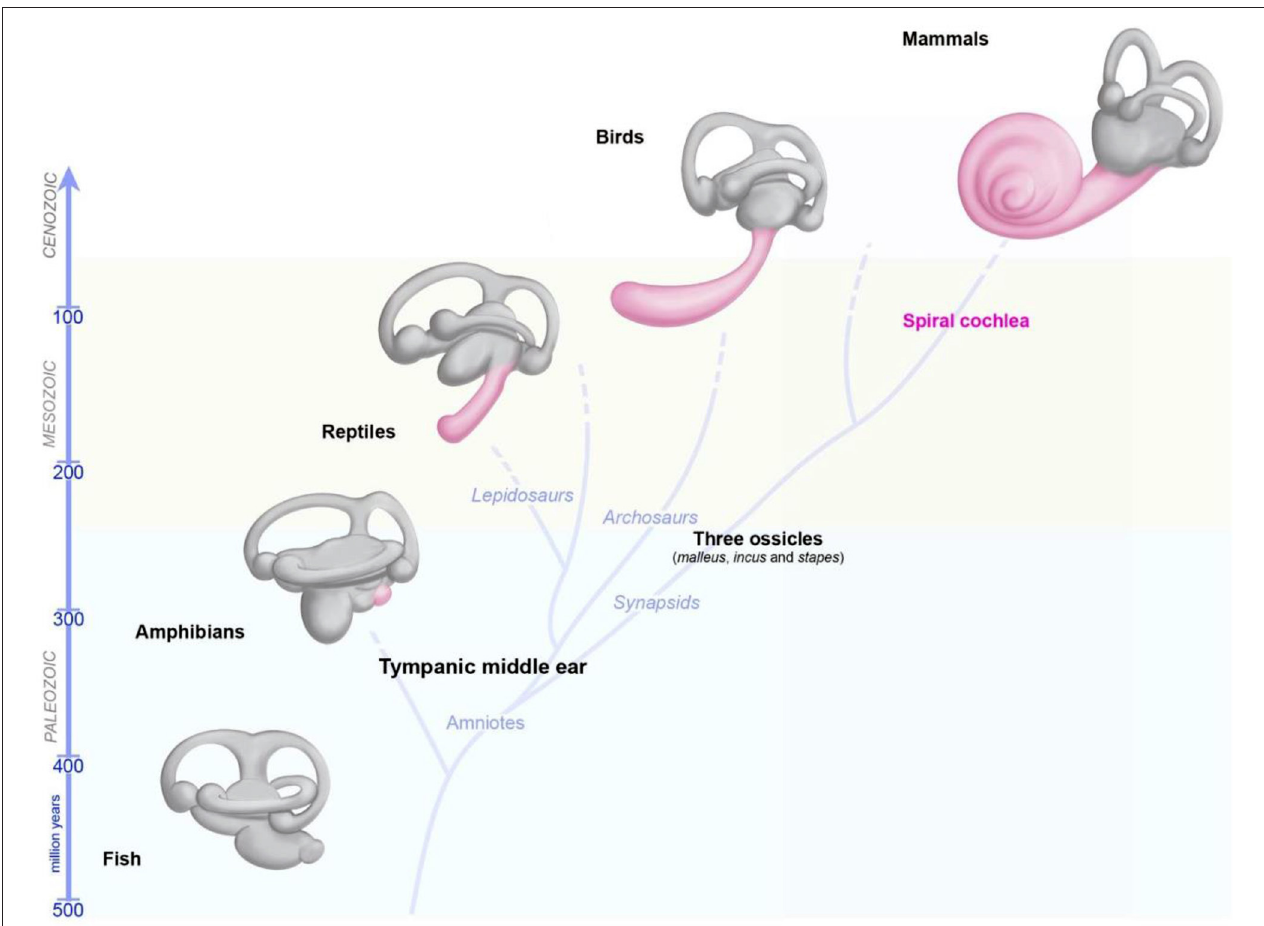
FIGURE 3 | Evolution of the inner ear in vertebrates. The global organization of the five vestibular end organs (utricle, saccule, and the three semicircular canals) has changed very little from fish to current mammals. A sense organ dedicated exclusively to hearing, the papilla, appeared for the first time in amphibians, and then progressively elongates in reptile and birds, and form a spiral in modern